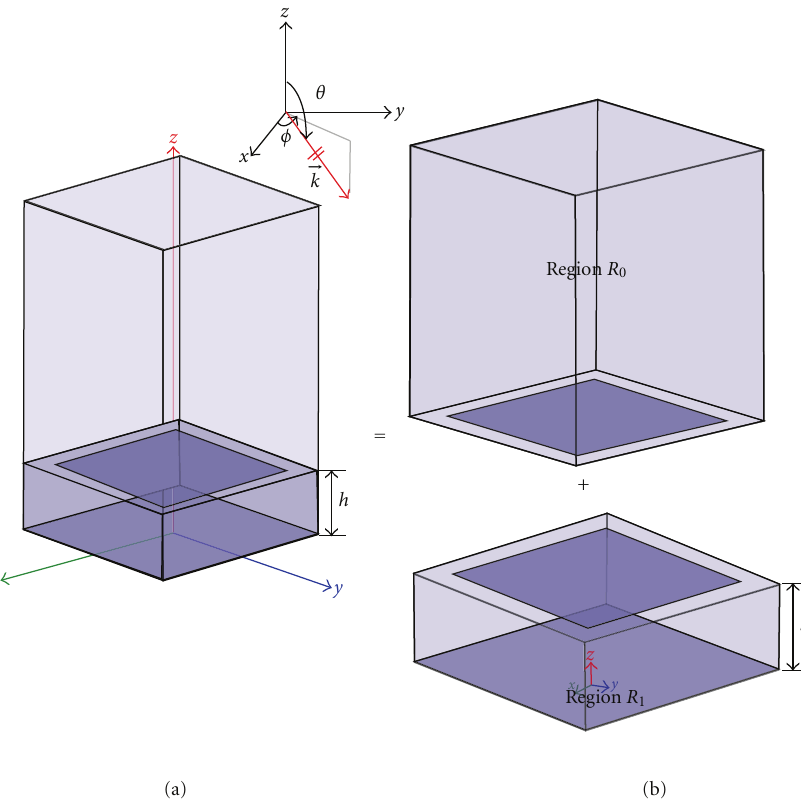
Figure 4: (a) A unit cell. (b) Separation of a Type B unit cell into two regions. Region R 0 is open at the top and has a PEC at the bottom. Equivalent magnetic currents (shown in light color at z = h ) exist just above the bottom PEC. Region R 1 has a PEC surface at the top and equivalent magnetic currents (shown in light color at z = h ) exist just below the top PEC. For Type A structures, the bottom of Region R 1 is open (not shown here). For Type B structures, it is a PEC (as